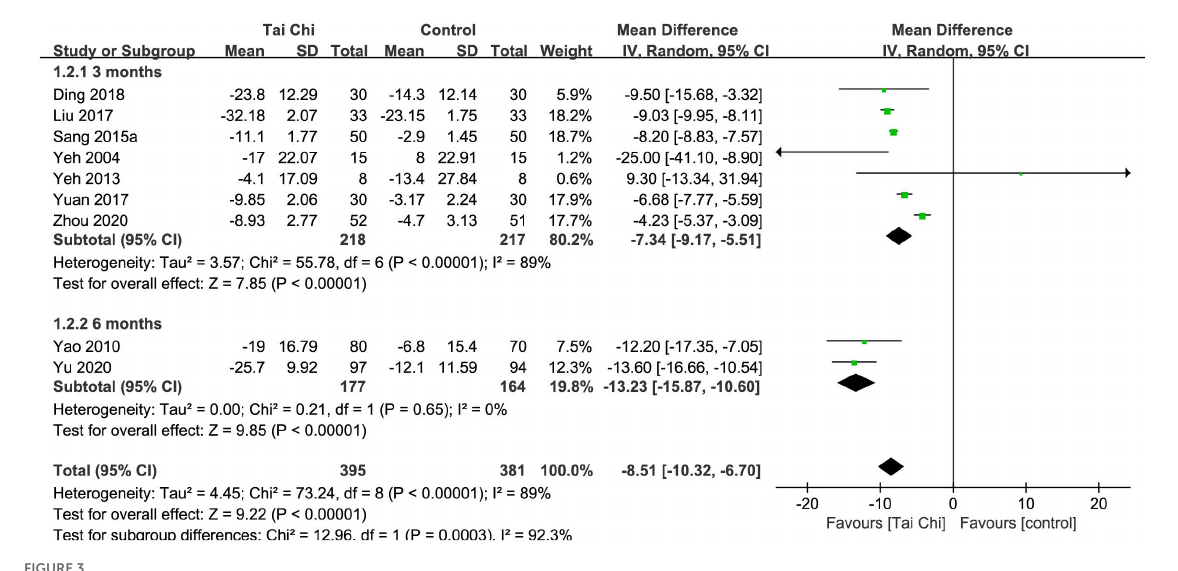
FIGURE3 Meta-analysis of MLHFQ in the Tai Chi group vs. the control group. CI, confidence interval; IV, inverse variance; SD, standard